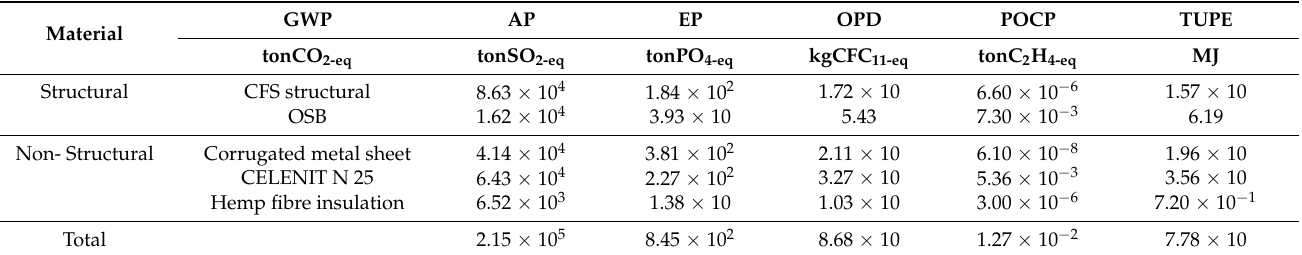
Figure 13. LCIA results: Roof. Table 14. Results of Life Cycle impact assessment: